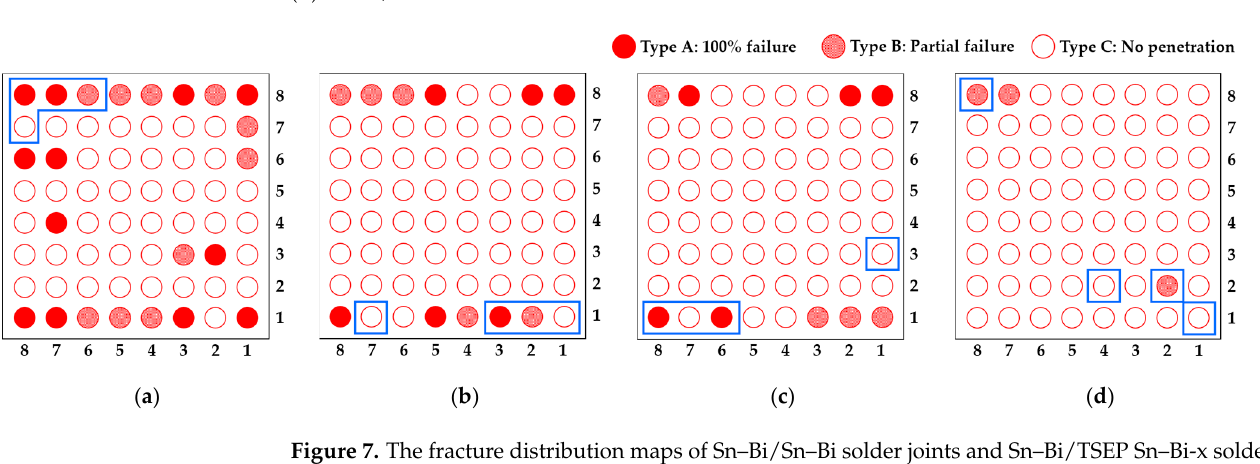
Figure 6. The crack modes of the Sn–Bi/Sn–Bi solder joints and Sn–Bi/TSEP Sn–Bi-x solder joints after the dye and pull test. ( a ) Sn–Bi/Sn–Bi. ( b ) Sn–Bi/TSEP Sn–Bi-3. ( c ) Sn–Bi/TSEP Sn–Bi-5. ( d ) Sn–Bi/TSEP Sn–Bi-7.